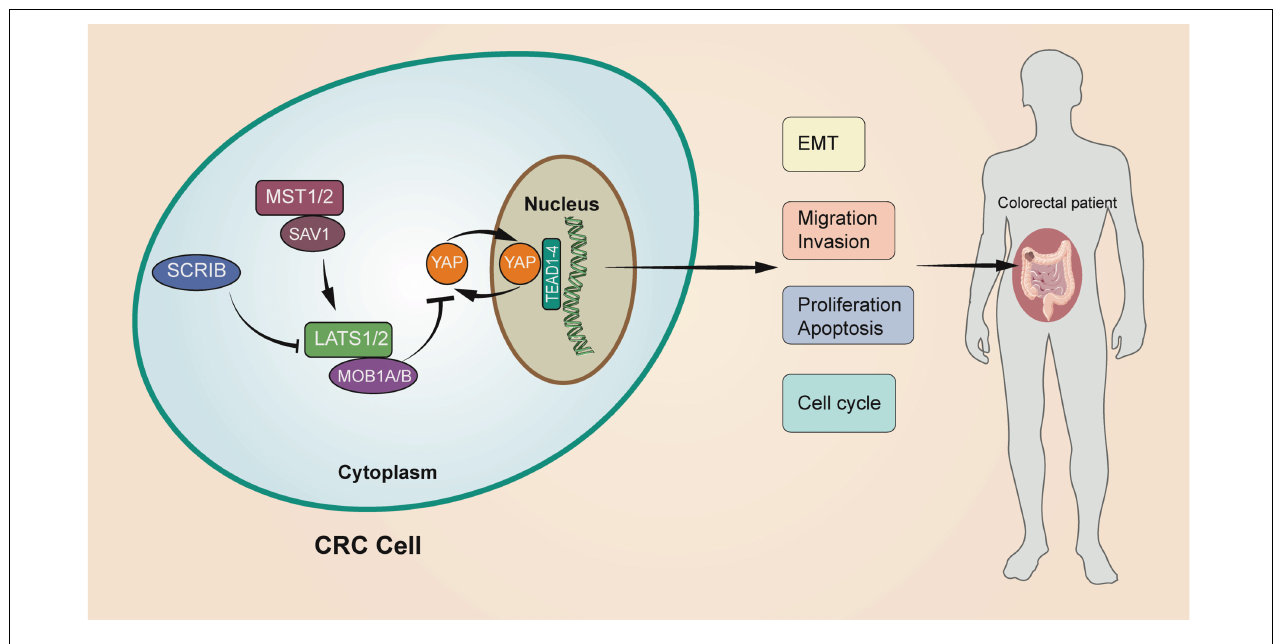
FIGURE 7 | A schematic model of the role of SCRIB in regulating CRC. The upregulation of SCRIB reduced the expression of LATS1/2 and MOB1A/B to further inhibit the phosphorylation of YAP. Unphosphorylated YAP can translocate to the nucleus to activate transcription of the target genes TEAD1-4. The SCRIB -YAP-Hippo axis ultimately affects the disease progression of CRC patients by affecting the proliferation, invasion, migration, and apoptosis of CRC